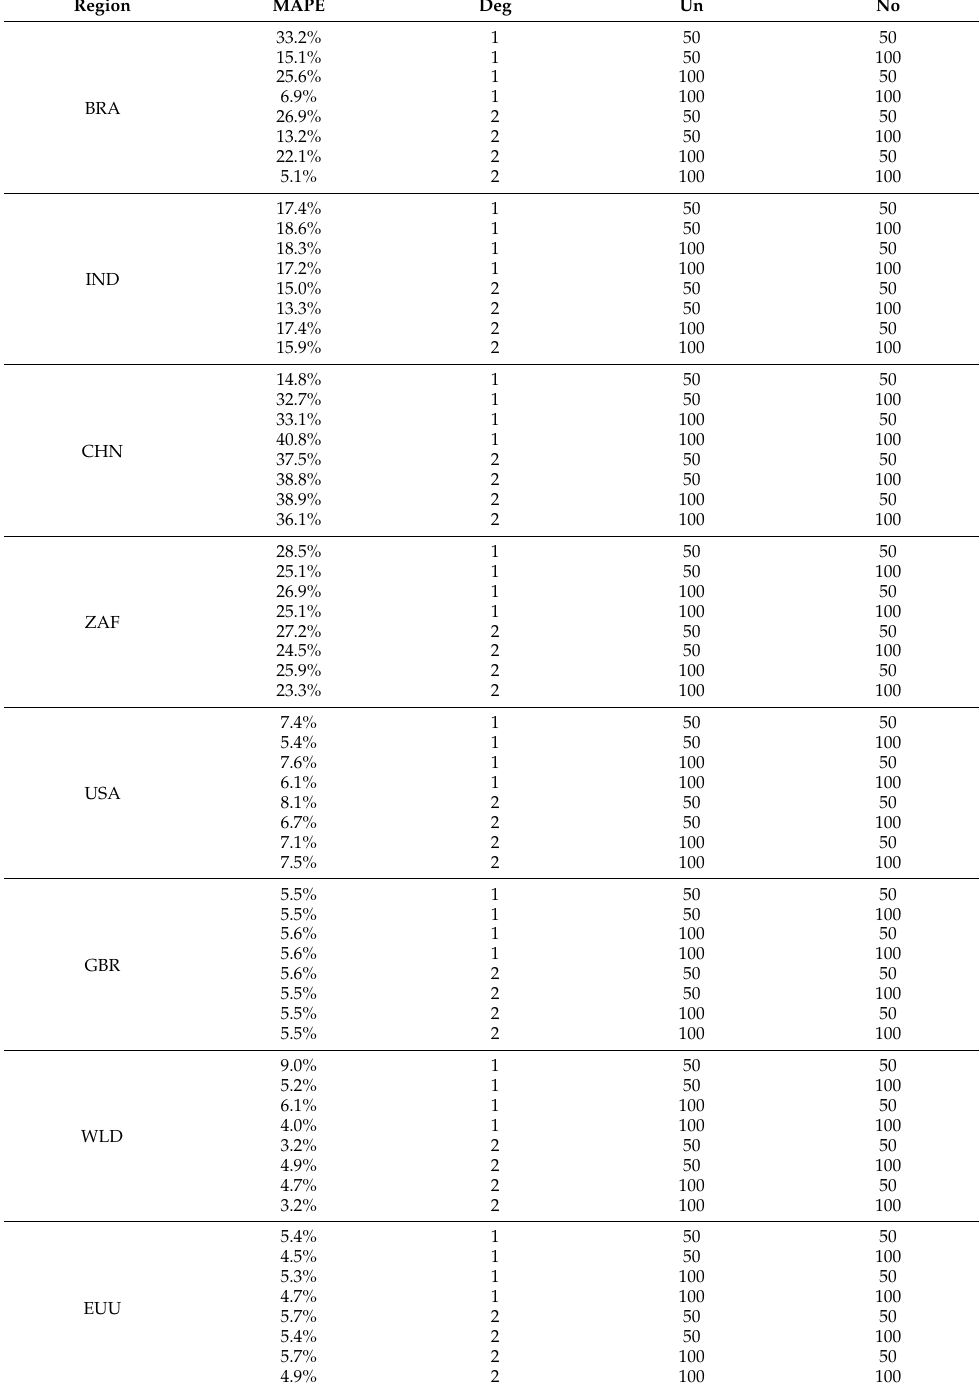
Table 10. Mean absolute percentage error (MAPE) on the test set using shallow neural networks for different values of the degree of the polynomial (Deg), number of neurons per hidden layer (Un), and number of epochs